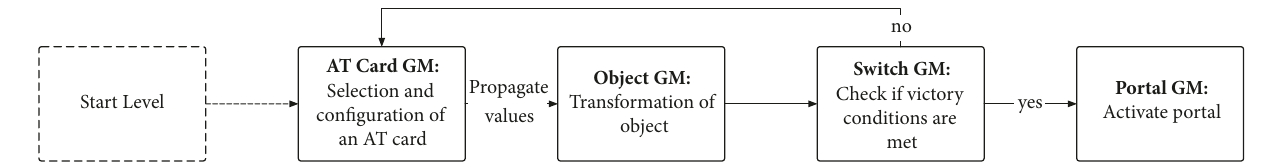
Figure 6: Solving a spatial puzzle requires players to select and to configure AT cards. The system then checks if the victory conditions are met.